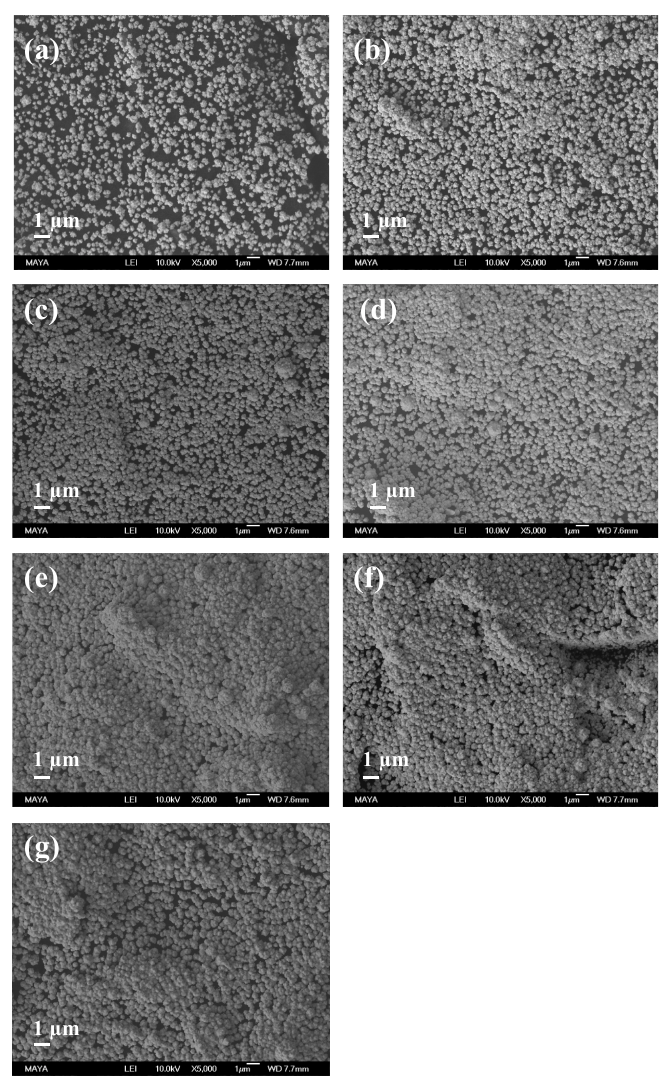
Figure 1. SEM images of AuNPs-modified GCEs obtained by sweeping the potential between 1.1 and − 0.1 V vs. Ag|AgCl sat for a given number of scans in 10 mM HAuCl 4 (0.5 M H 2 SO 4 ) : ( a ) 5, ( b ) 10, ( c ) 15, ( d ) 20, ( e ) 25, ( f ) 30 and ( g ) 35.